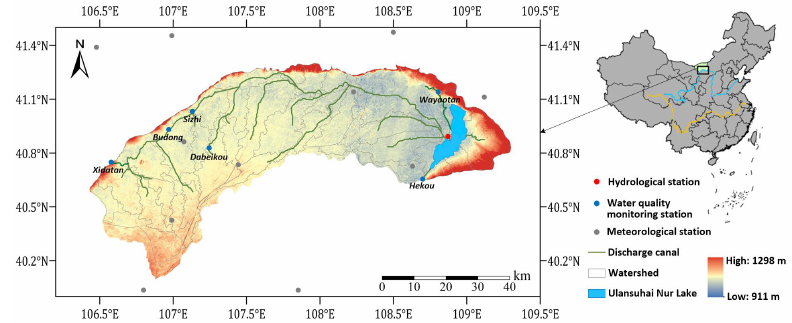
Figure 1. Location of the Hetao